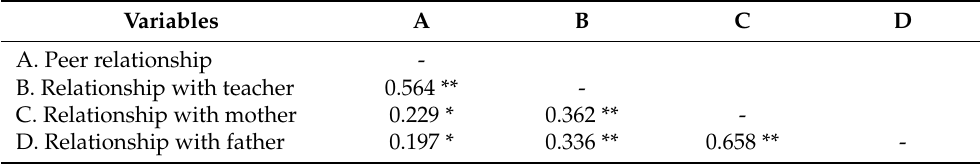
Table 1. Correlation analysis between dimension of TRI in the middle school students.